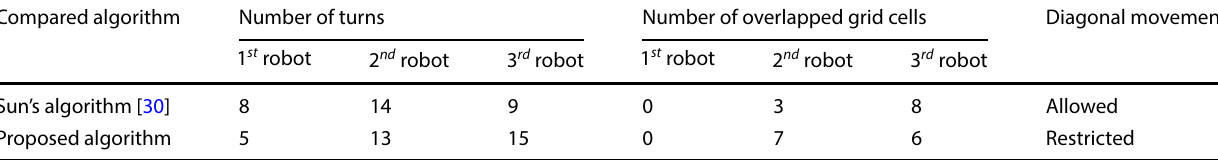
Table 12 Comparison of proposed algorithm with Sun’s algorithm [30] Compared